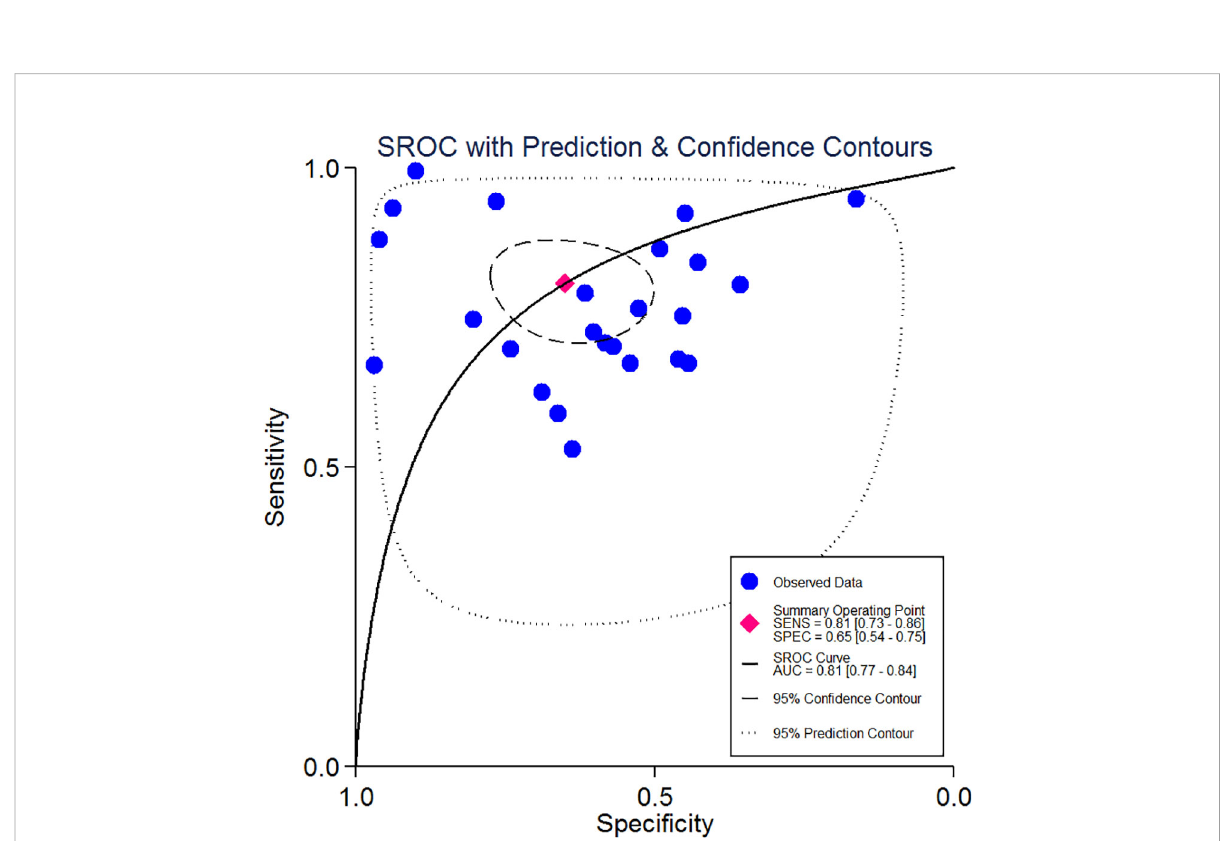
FIGURE 4 Summary receiver operating characteristics curve and the 95% con fi dence contour and 95% prediction